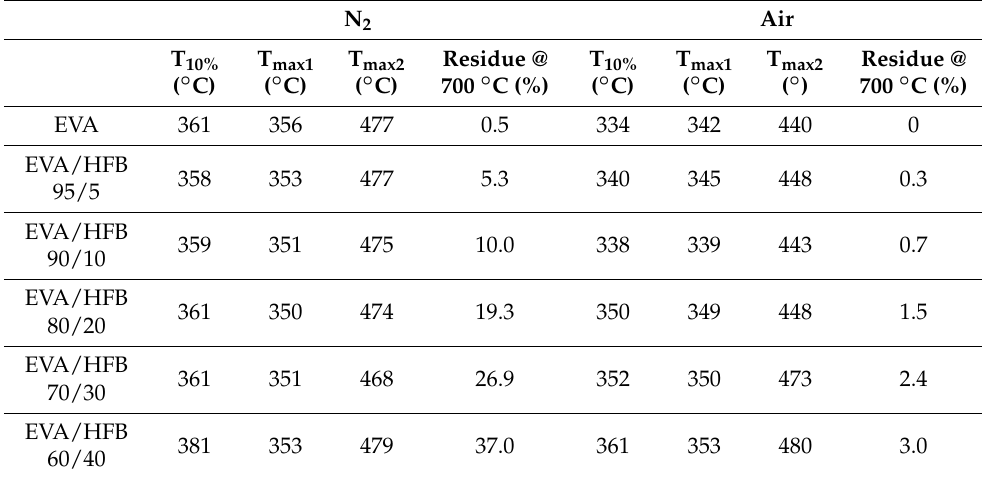
Figure 3. TG and dTG curves of EVA and its composites performed in: ( A ) nitrogen: and ( B ) air atmosphere (heating rate: 10 °C/min). Table 2. Thermogravimetric data for EVA and its